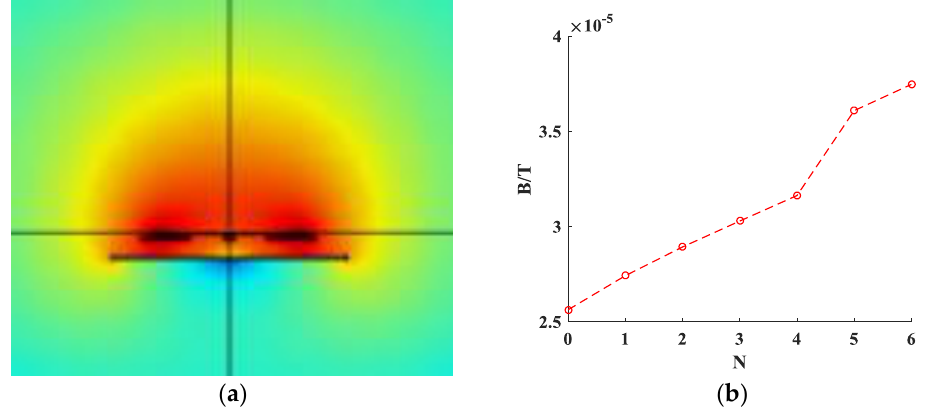
Figure 12. ( a ) Magnetic field distribution; ( b ) Magnetic changing curve vs. numbers of ferrite cores.